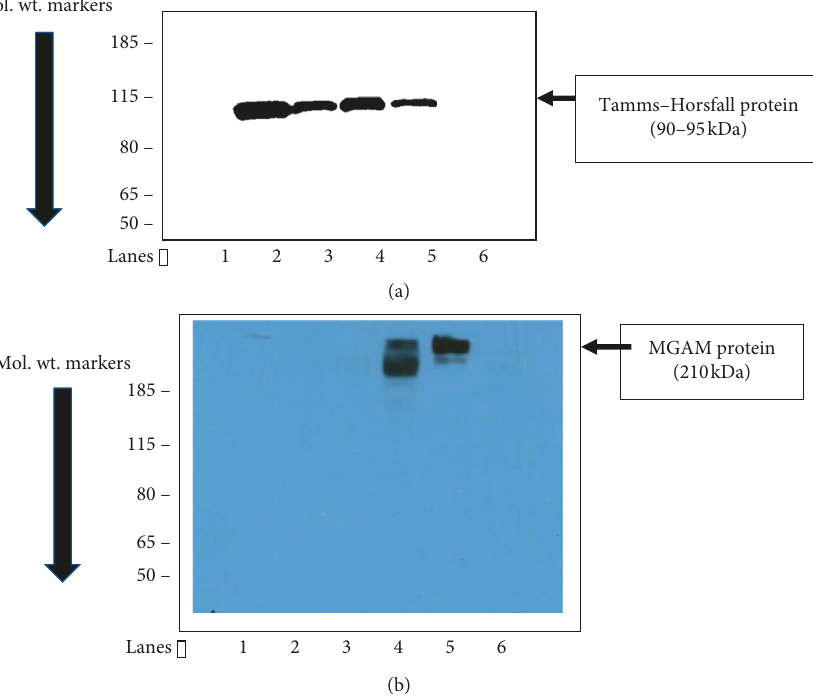
Figure 4: (a, b) Immunoblotting of cirrhosis-AKI urine exosomes for maltase-glucoamylase (MGAM). (a) Tamms–Horsfall protein blot for exosome loading control. (b) MGAM protein blot. Lanes 1 and 6: blank, lanes 2 and 3: normal control (noncirrhotic) urine exosome protein, and lanes 4 and 5: cirrhotic subjects with ascites and kidney